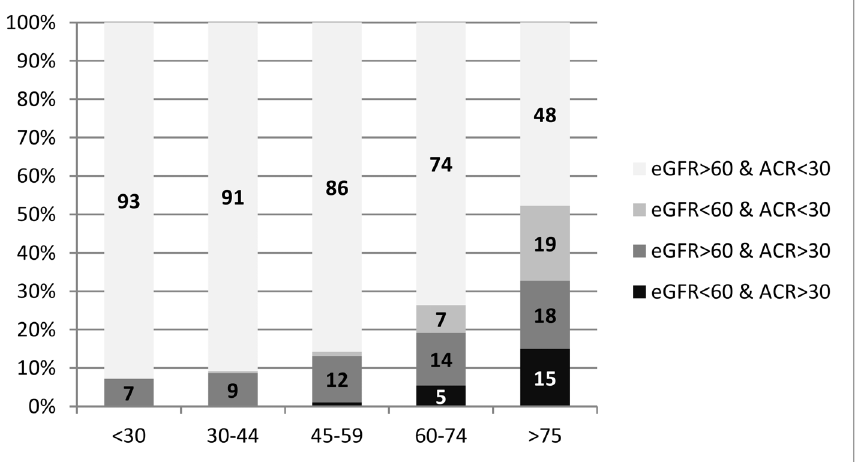
Figure 1. Percentage of patients with reduced eGFR and/or elevated ACR for different age groups. ACR, albumin-creatinine ratio (given as mg/mmol); eGFR, estimated glomerular filtration rate (given as ml/min/1.73 m 2 ).